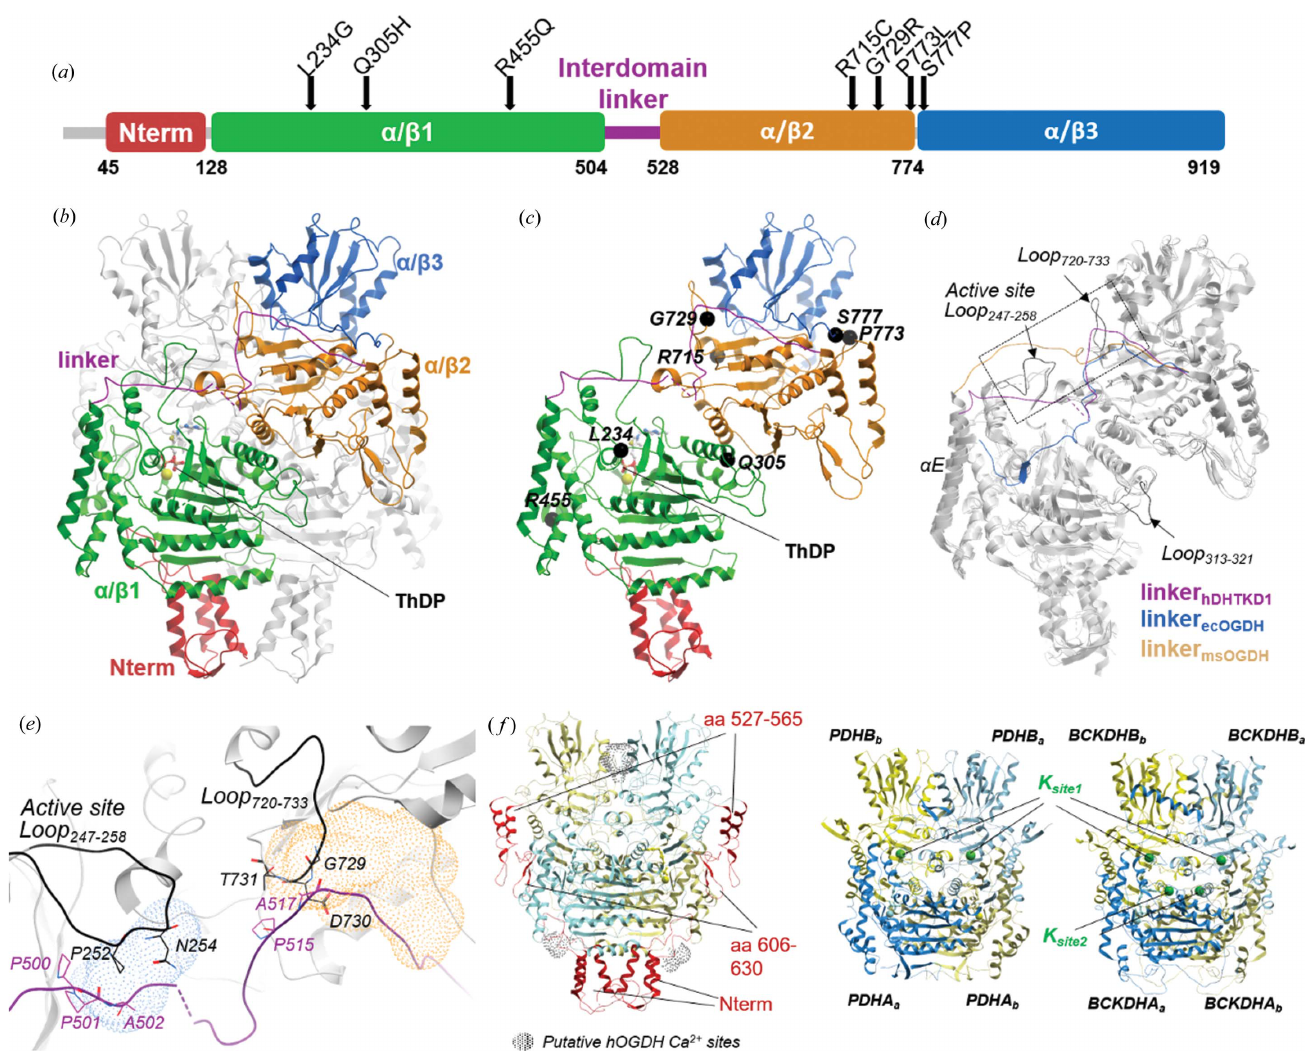
Figure 1 Overall structure of hDHTKD1. ( a ) A schematic of hDHTKD1 domain organization, indicating disease-causing missense mutations with arrows. ( b ) Structure of the hDHTKD1 homodimer, where one subunit is coloured according to the domain organization from panel ( a ) and the other subunit is coloured grey. ThDP co-factors and Mg 2+ ions are shown as sticks and spheres, respectively. ( c ) Sites of missense mutations are shown as black spheres on one hDHTKD1 protomer [same view as panel ( b )]. ( d ) Structural superposition of hDHTKD1, ecOGDH (PDB code 2jgd) and msOGDH (PDB code 6r2b; Wagner et al. , 2019) highlighting their different inter-domain linkers (coloured purple, blue and light brown, respectively). ( e ) A magnified view of the dotted box in panel ( d ), showing how the hDHTKD1 inter-domain linker (purple) packs against two loop regions (black). Binding positions for the allosteric effectors AMP in the ecOGDH structure (PDB code 2jgd) and acetyl-CoA in the msOGDH structure (PDB code 2y0p; Wagner et al. , 2011) are shown as blue and brown meshes, respectively. ( f ) Overall architectures of the hDHTKD1 homodimer (left), the human (PDHA–PDHB) 2 heterotetramer (middle, PDB code 1ni4; Ciszak et al. , 2003) and the human (BCKDHA–BCKDHB) 2 heterotetramer (right, PDB code 1dtw; Ævarsson et al. , 2000) are shown. hDHTKD1 homodimer has a larger volume because of the insertions coloured